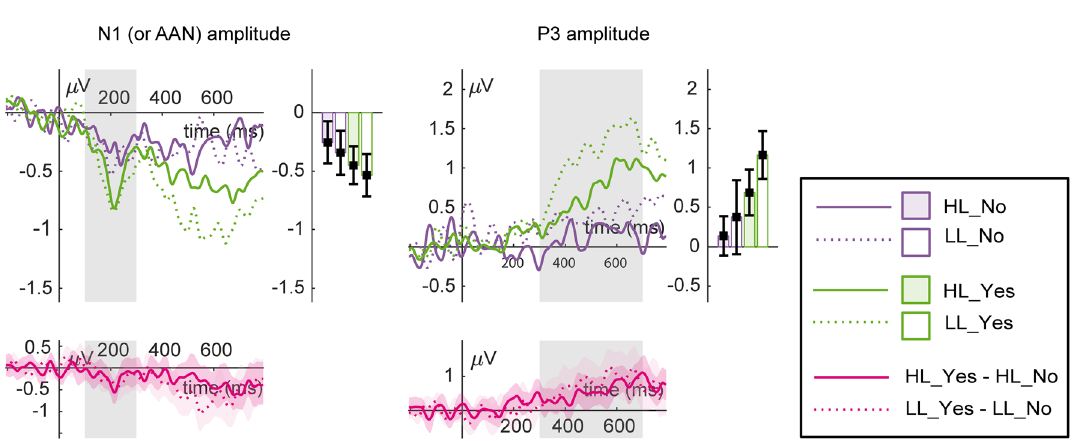
Figure 7. ERPs ( n = 34) for the two report conditions (yes, no) and the two load conditions (LL, HL) in the N1 time range (left panel) and the P3 time range (right